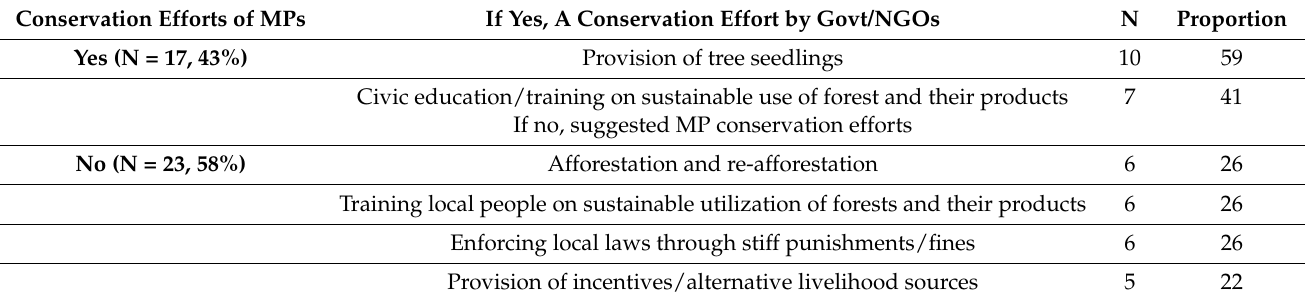
Conservation Efforts of